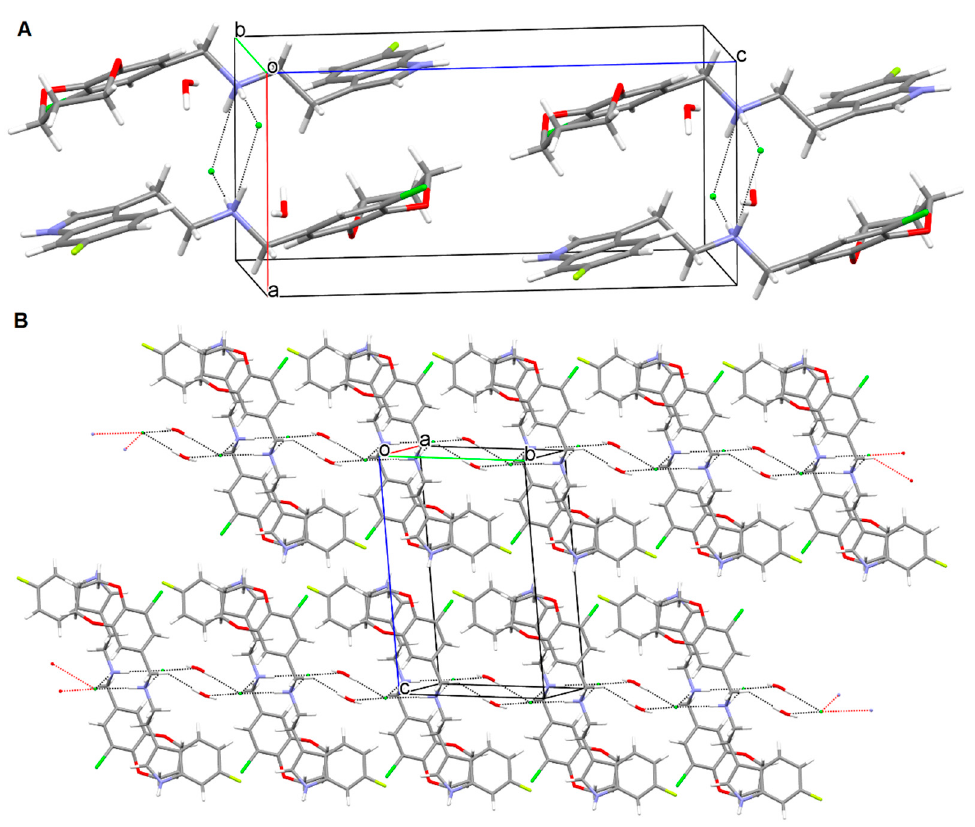
Figure 2. The molecular structure of D2AAK5 with displacement ellipsoids drawn at the 50% probability level.